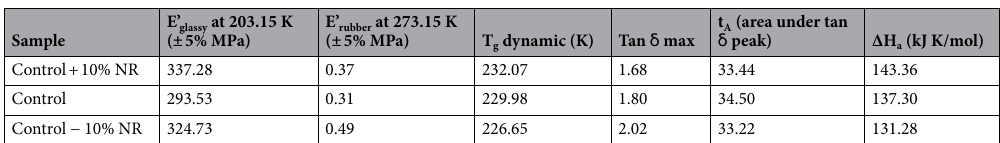
Table 6. Parameters obtained from the dynamic mechanical analysis of various foam